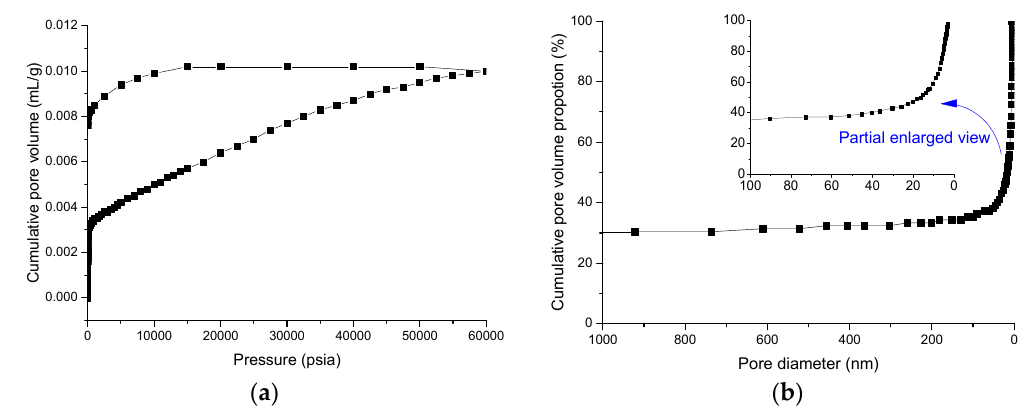
Figure 1. Micropore size analysis. ( a ) Graph of pore volume vs. pressure showing Hg hysteresis and retention; and ( b ) pore diameter distribution.